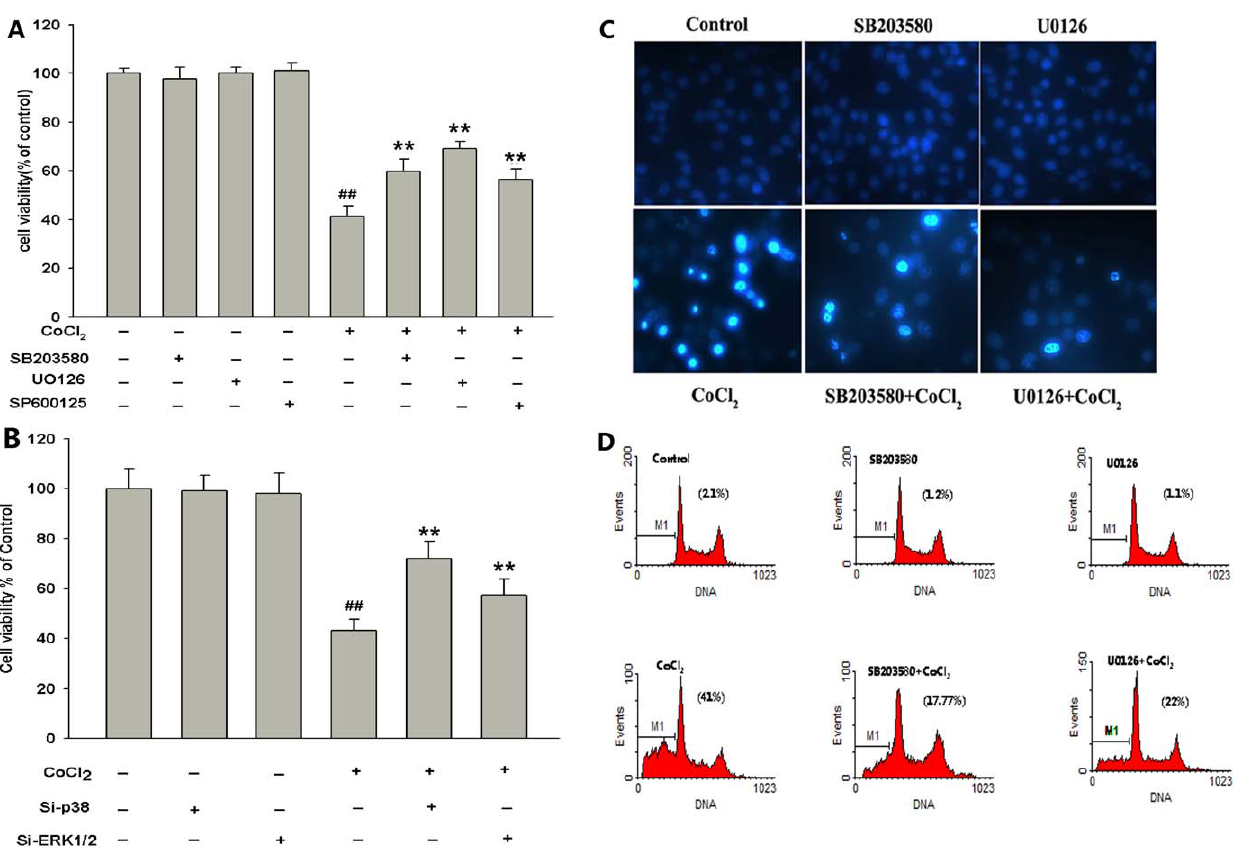
Figure 8. ERK1/2, p38MAPK and JNK pathways mediated CoCl 2 -induced injuries in PC12 cells. (A) and (B) The cell viability was assessed by the CCK-8 reduction method described in ‘Materials and methods’. The cells were treated with the indicated treatments. (C) Morphological changes in apoptotic cells assessed by Hoechst 33258 staining. Arrow indicates cells with apoptotic nuclear condensation and fragmentation. Control: untreated cells; SB203580: cells were treated with 20 m mol/L SB203580 for 60 min alone; UO126: cells were treated with 10 m mol/L UO126 for 120min alone; CoCl 2 : cells were treated with 600 m mol/L CoCl 2 for 48 h; SB203580 + CoCl 2 : cells were pretreated with p38 inhibitor SB203580 (20 m mol/L) for 60 min followed by exposure of cells to 600 m mol/L CoCl 2 for 48 h; UO126 + CoCl 2 : cells were pretreated with ERK1/2 inhibitor UO126 (10 m mol/L) for 120 min followed by exposure of cells to 600 m mol/L CoCl 2 for 48 h. (D) Results from FCM analysis. Data are the mean 6 SE (n=3). ## P , 0.01 compared with control; ** P , 0.01 compared with CoCl 2 -treated